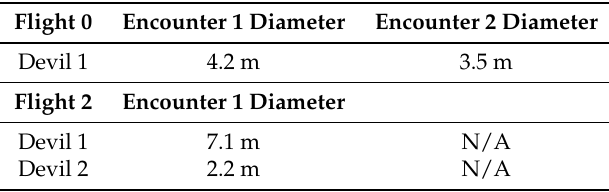
Table 1. Dust devil diameters inferred from the video collected from onboard the